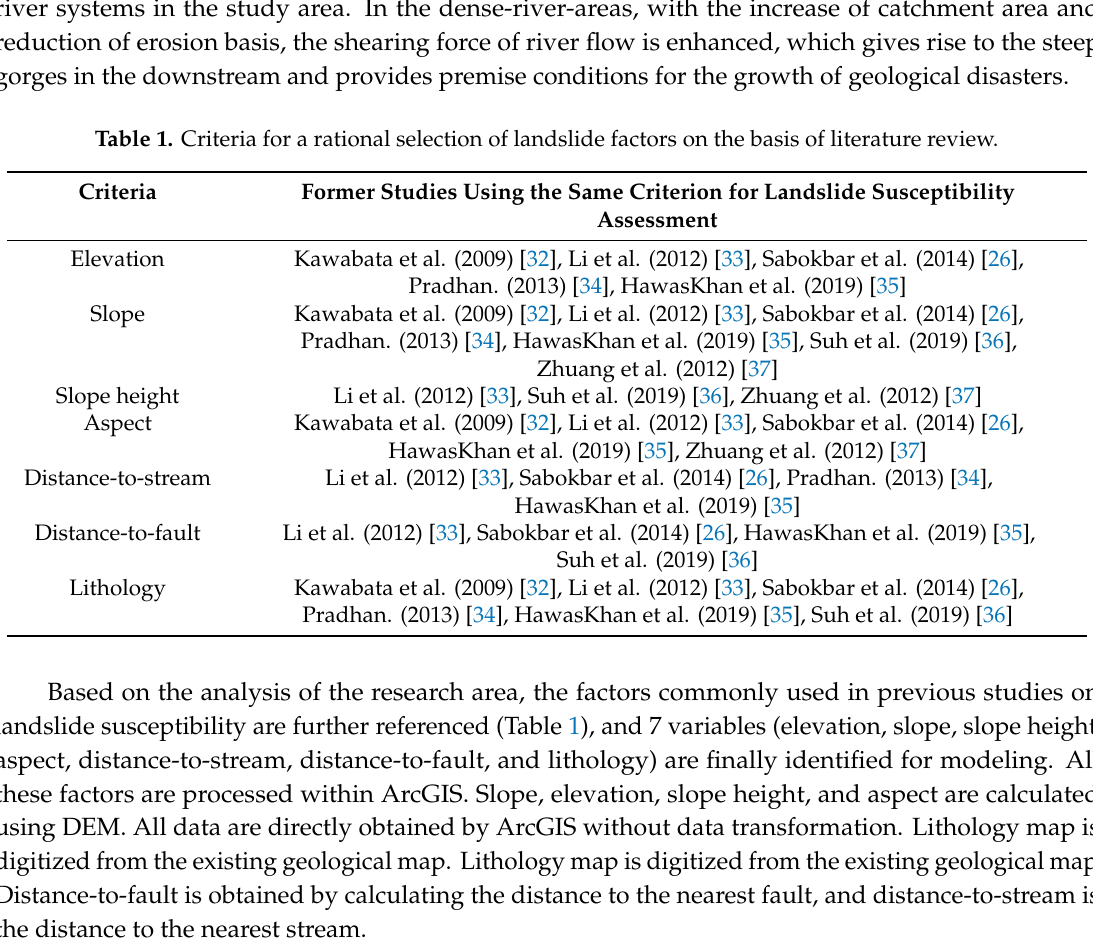
Table 1. Criteria for a rational selection of landslide factors on the basis of literature review. Criteria Former Studies Using the Same Criterion for Landslide Susceptibility Assessment Elevation Kawabata et al. (2009) [32], Li et al. (2012) [33], Sabokbar et al. (2014) [26], Pradhan. (2013) [34], HawasKhan et al. (2019) [35] Slope Kawabata et al. (2009) [32], Li et al. (2012) [33], Sabokbar et al. (2014) [26],